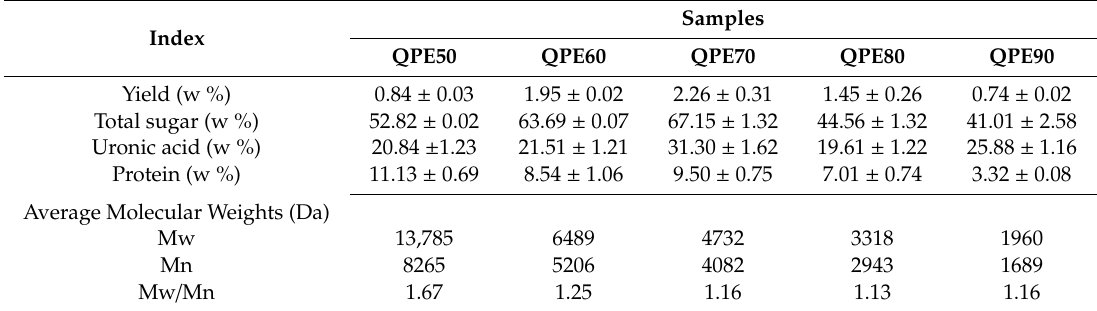
Table 1. Yield, chemical composition and molecular weight of QPs precipitated by gradient ethanol.